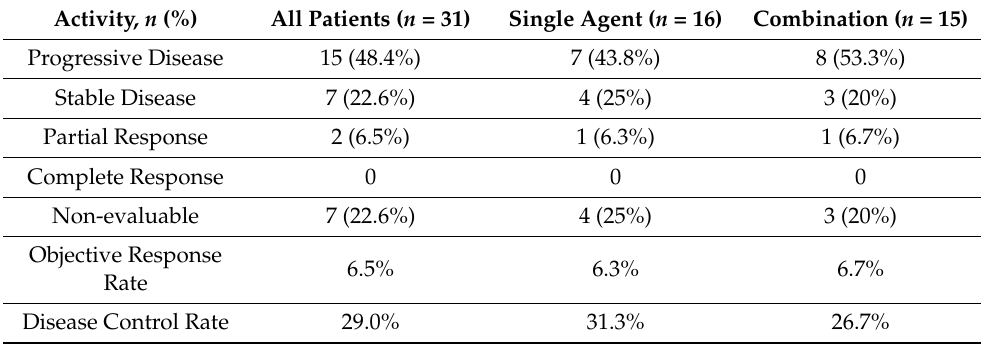
Table 4. Best objective response, post-immune checkpoint inhibitors